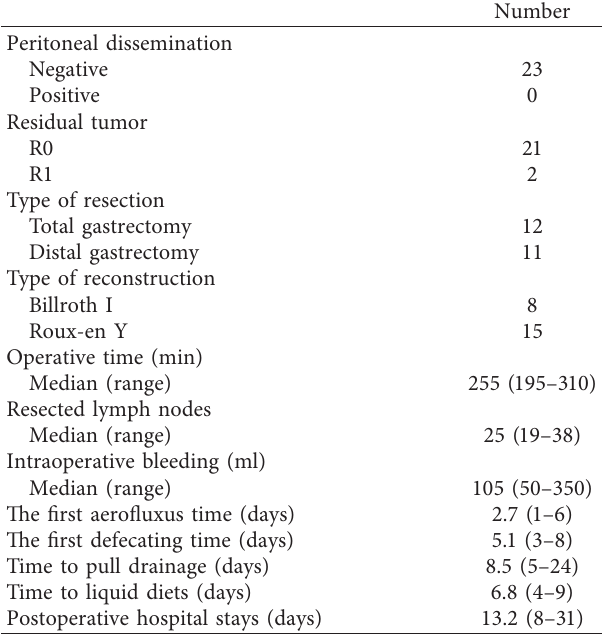
Table 3: Operative findings and postoperative outcomes ( n �